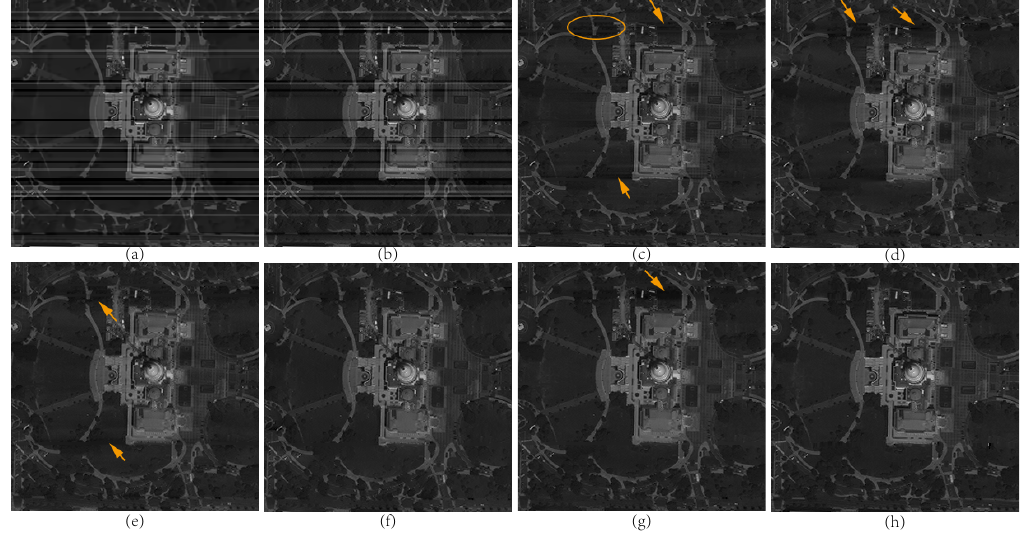
Figure 14. Comparison results for simulated stripe Washington DC multispectral data S6. ( a )